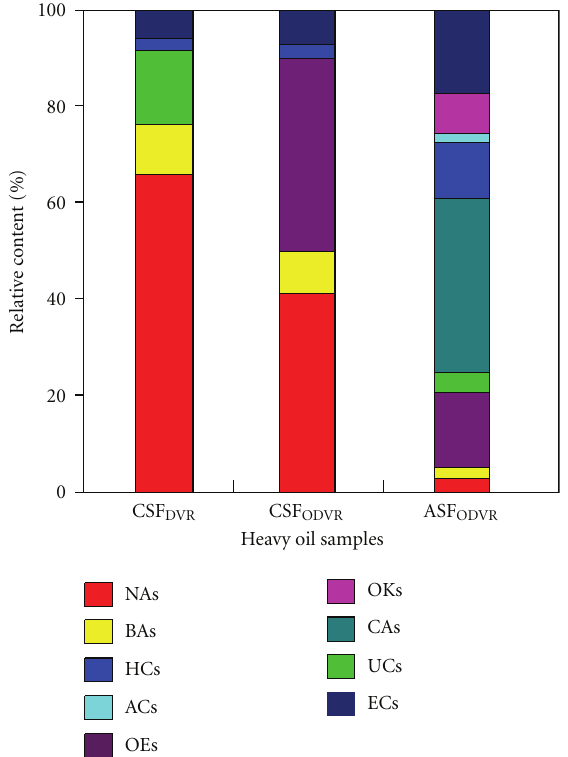
Figure 5: Distributions of group components in solution of CSF DVR , CSF ODVR and ASF ODVR